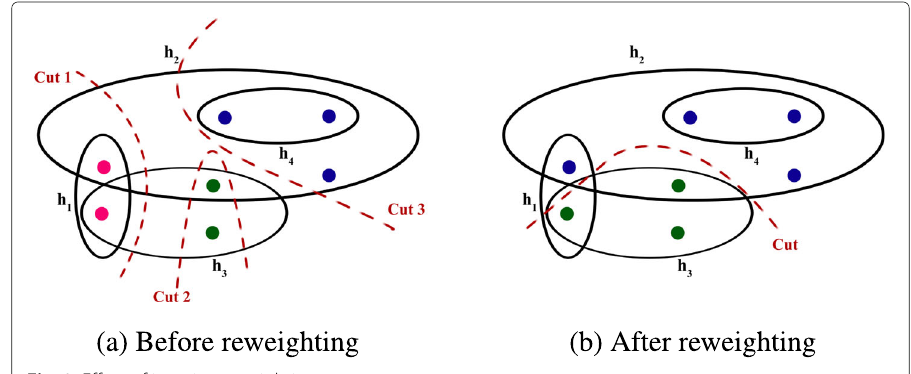
Fig. 2 Effect of iterative reweighting